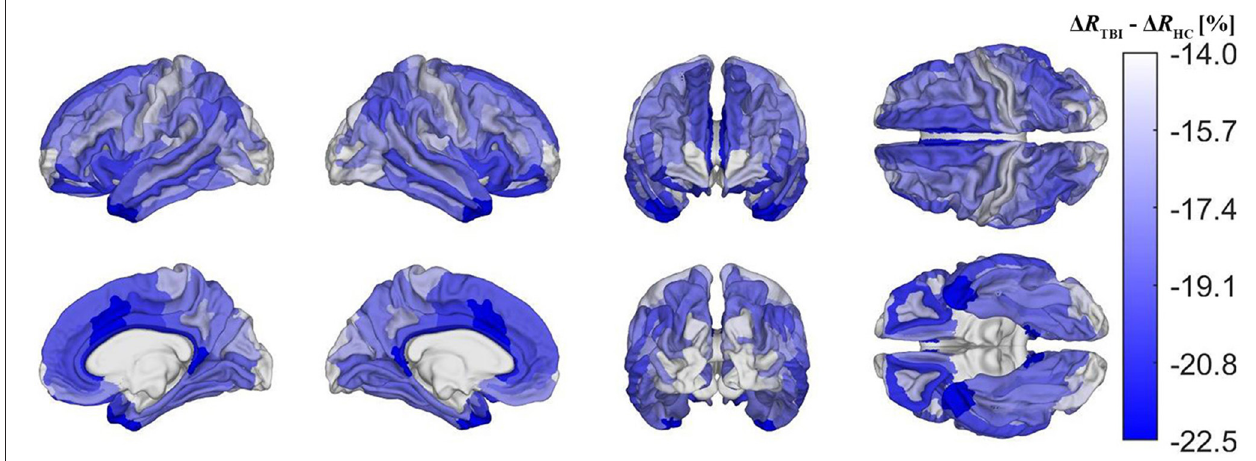
FIGURE 7 | Cortical map of group differences in 1 R , corrected for multiple comparisons. These group differences convey deviations in mTBI-related demyelination from typical aging-related demyelination. Group differences were calculated as 1 R TBI − 1 R HC , where 1 R TBI and 1 R HC are 1 R for the mTBI and HC groups, respectively. Darker blue shades indicate that mTBI participants experience a greater percentage of myelin loss than HCs. The former experience a greater relative amount of demyelination in temporal, cingulate, and insular regions, but also a relatively smaller amount in the pre- and postcentral gyri, as well as in occipital regions.